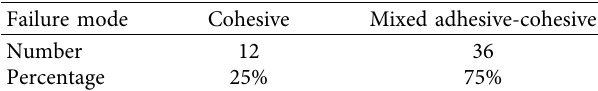
Table 4: Number and percentage (%) of failure mode.